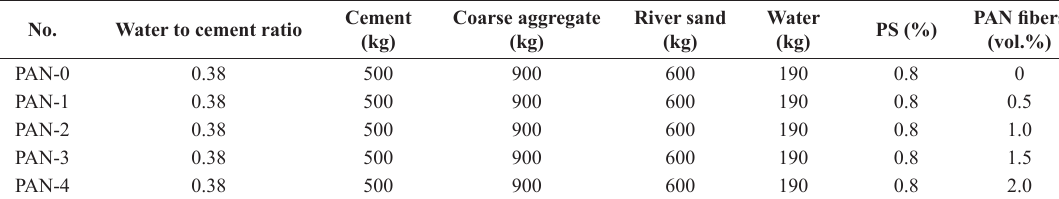
Table 3. Mix proportion of the prepared PAN fiber reinforced